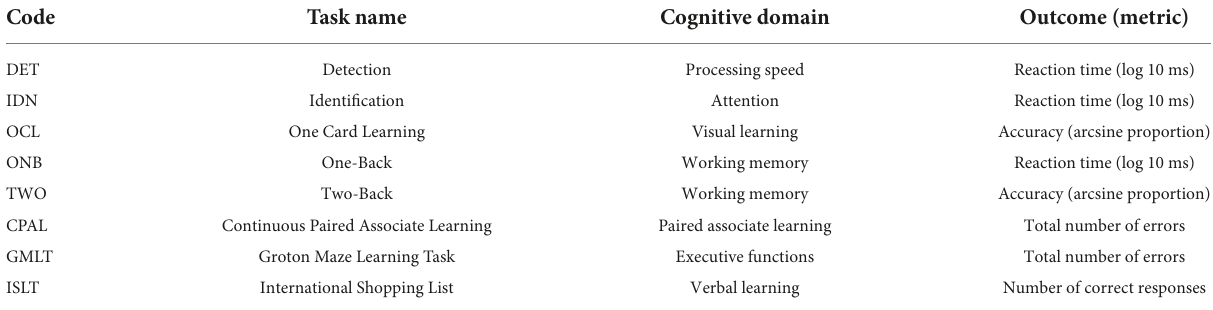
TABLE 2 List of cogstate tasks, corresponding cognitive domains, and main outcome measures. Code Task name DET Identification One Card Learning